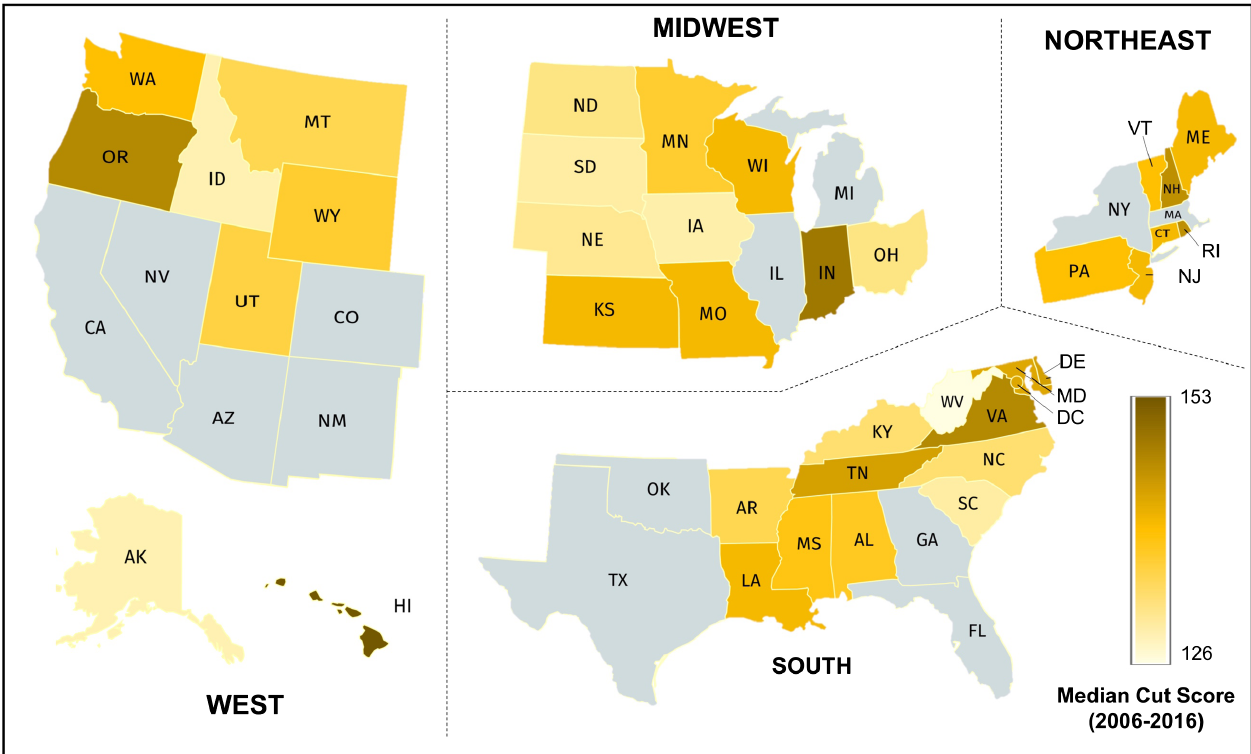
FIG. 1. Median Praxis physics subject assessment cut scores from 2006 to 2016. Individual data reported by each state was used to determine the minimum scaled score needed to be awarded certification in the state. The median of these values for each state between 2006 and 2016 is depicted. States were assigned a score if they accepted Praxis physics subject assessment testing for certification in any year within this timeframe. Those that did not are shaded in gray. A scaled score of 140 corresponds to a raw percentage score of approximately 54%. Source: Derived from data provided by Educational Testing